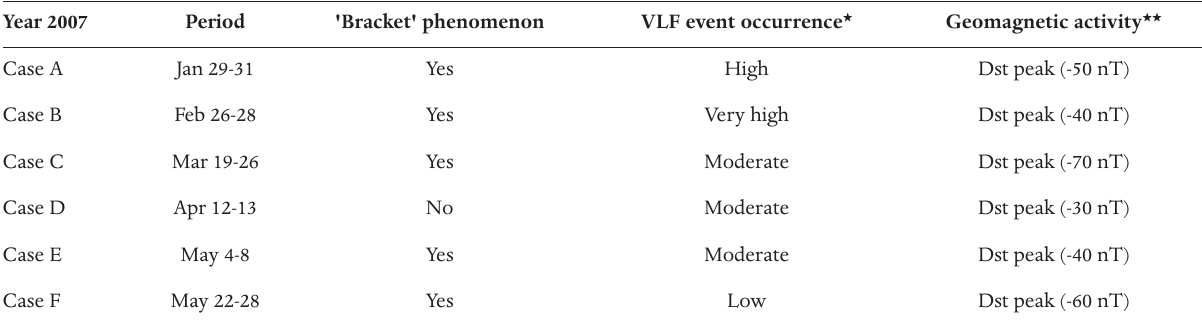
Table 2. Summary of the cases of interest. *, Very high occurrence is >200 events per day, high occurrence is ~80-100 events per day, mod- erate occurrence is 40-60 events per day, and low occurrence is <10 events per day; **, values